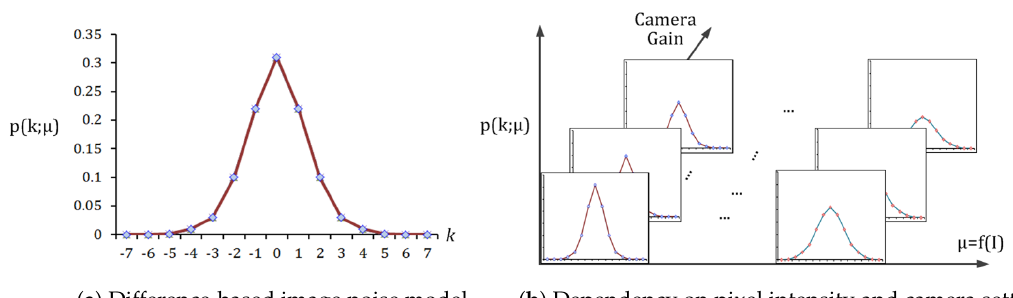
Figure 1. Intensity difference-based image noise model [15]. Here, I and k denote a pixel intensity and the difference in intensity between two random pixels, respectively; and, p ( k ) and µ are the noise probability function and its parameter,